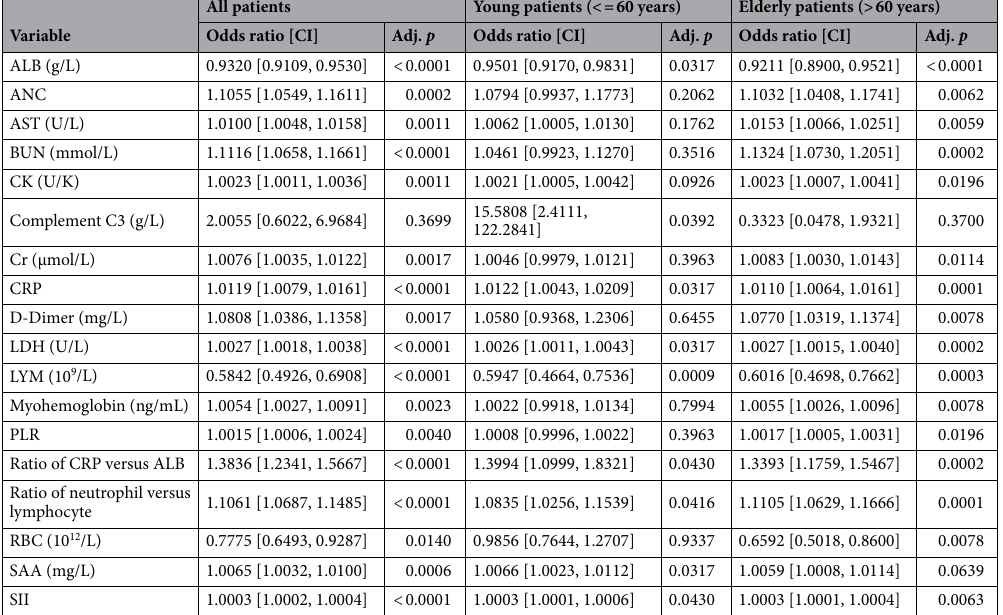
Table 2. Univariable logistic regression for the outcome “severe versus mild”. The p values were adjusted for multiple testing separately for the analysis of all patients, young patients, and elderly patients. Increased levels of complement C3 and SAA were associated with an increased risk for severity only in the young patient cohort. Supplementary Table 1 contains the results for all